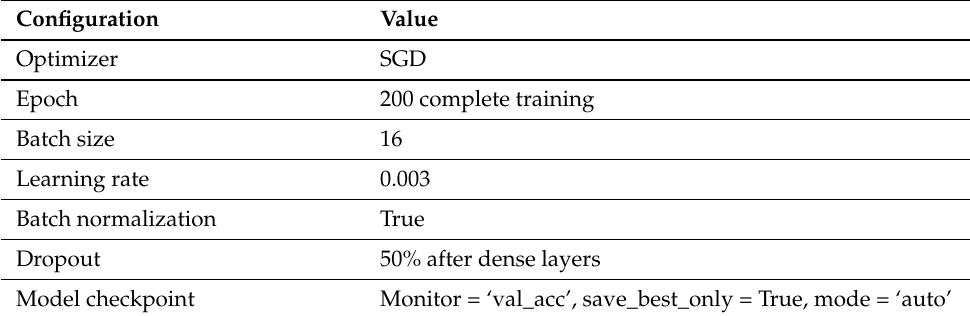
Table 2. Hyperparameters